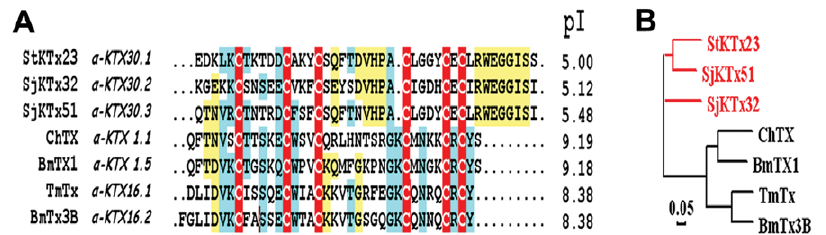
Figure 3. New subfamily of acidic a -KTx30. (A) Multiple sequence alignment of StKTx23, SjKTx32, and SjKTx51 with other a -KTxs; (B) Phylogenetic tree of three new acidic toxins with other related a -KTxs.